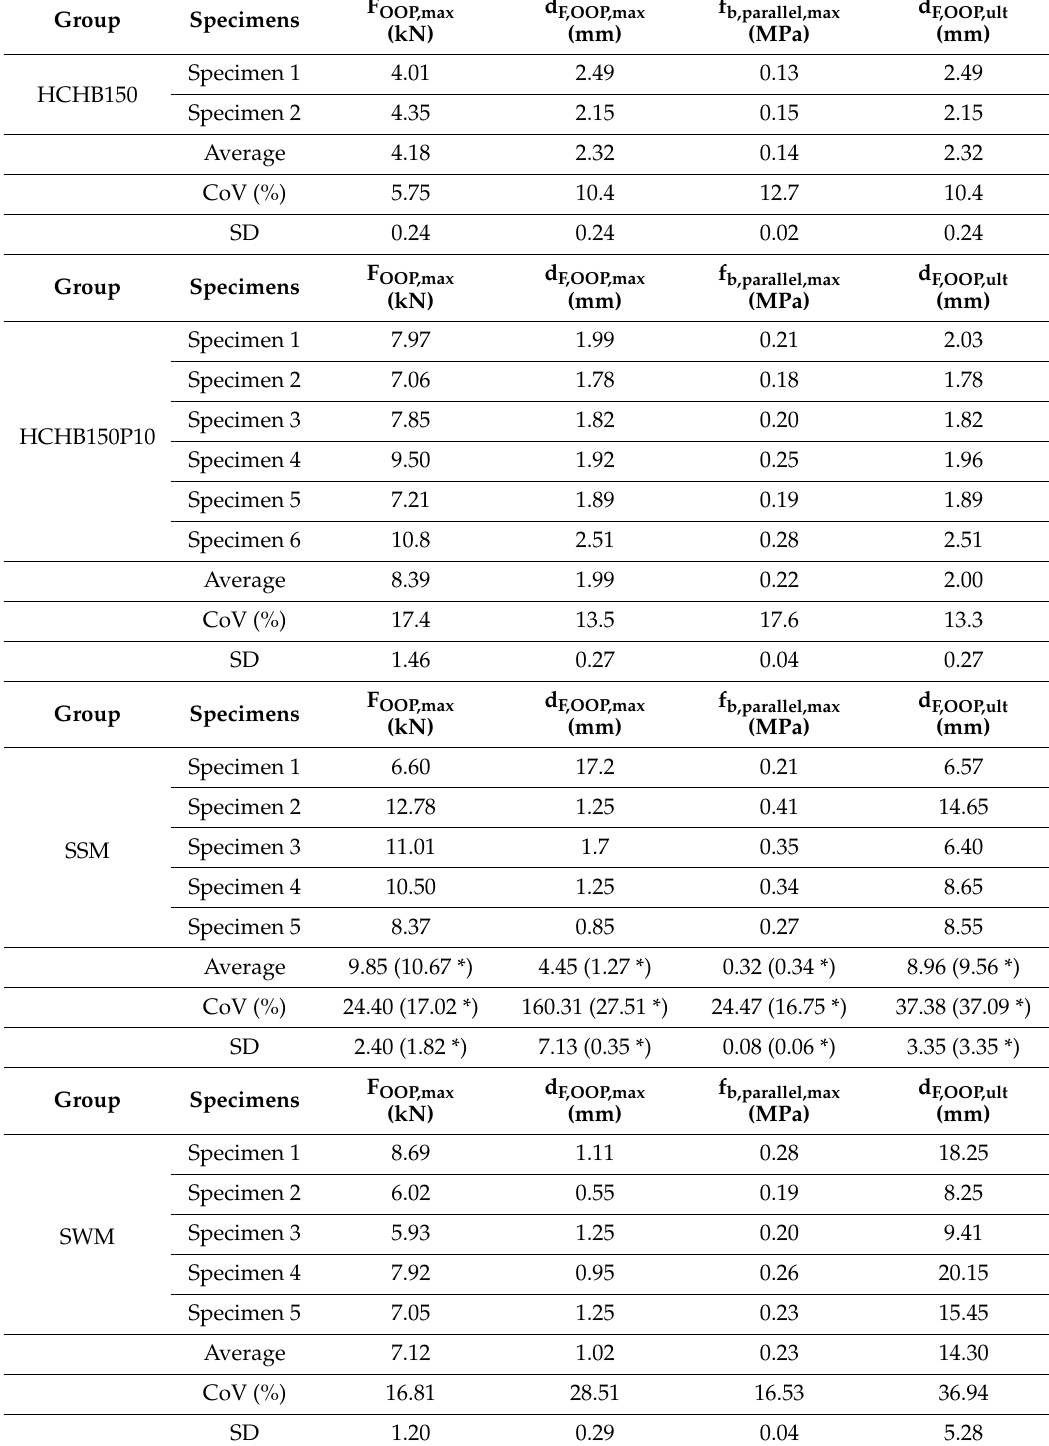
Table 2. Summary results of the flexural strength